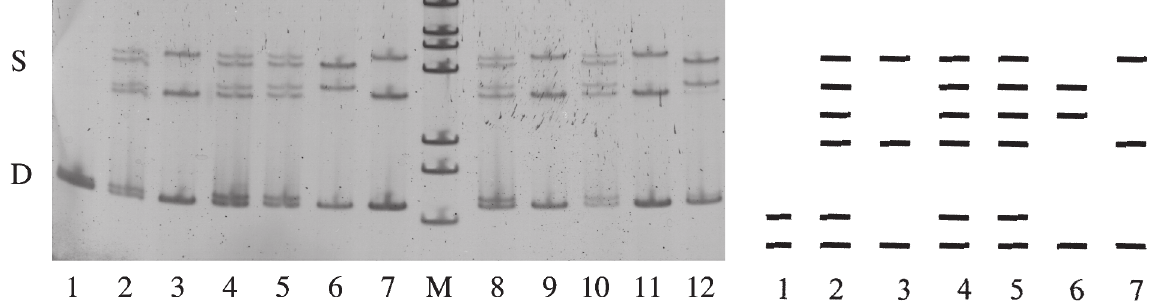
Fig. 2. – SSCP analyses of Ag4 DNA sequence. S: single-stranded DNA, D: double-stranded DNA, M: pGEM DNA marker, (Promega), lane 1: not denaturated DNA, lanes 2, 4, 5, 8, 10: Heterozygotes A1A3, lanes 3, 7, 9, 11: Homozygotes A1A1, lanes 6 and 12: Homozygotes